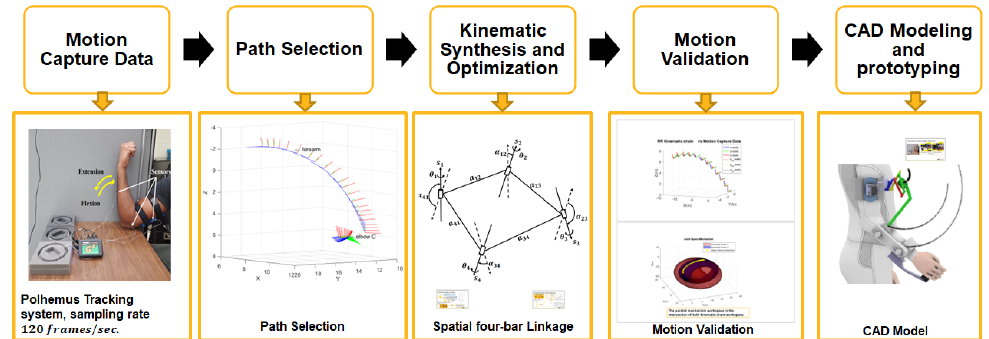
Figure 1. Exoskeleton synthesis methodology.